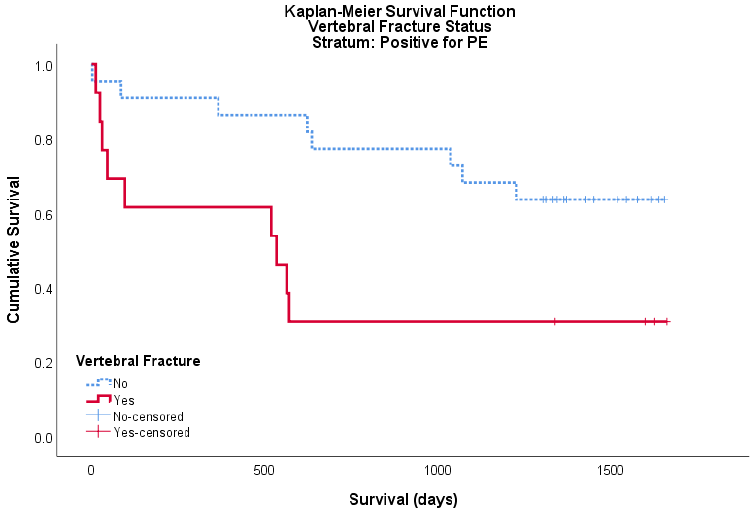
Figure 2. Kaplan–Meier survival curve showing the cumulative survival of patients with (red / solid) and without (blue / broken) a vertebral fracture on CTPA for patients positive for pulmonary embolism (PE). Censored data is shown as ‘ + ’ in its respective